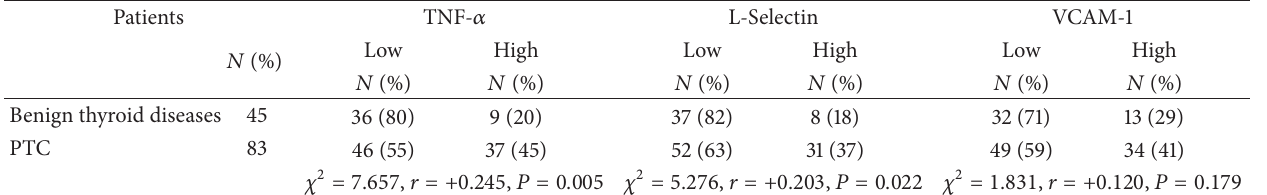
Table 5: Correlation of tumoural protein expression of TNF- 𝛼 , L-Selectin, and VCAM-1 with clinicopathological parameters of PTC patients. TNF- 𝛼 L-Selectin VCAM-1 Parameter 𝑁 Low